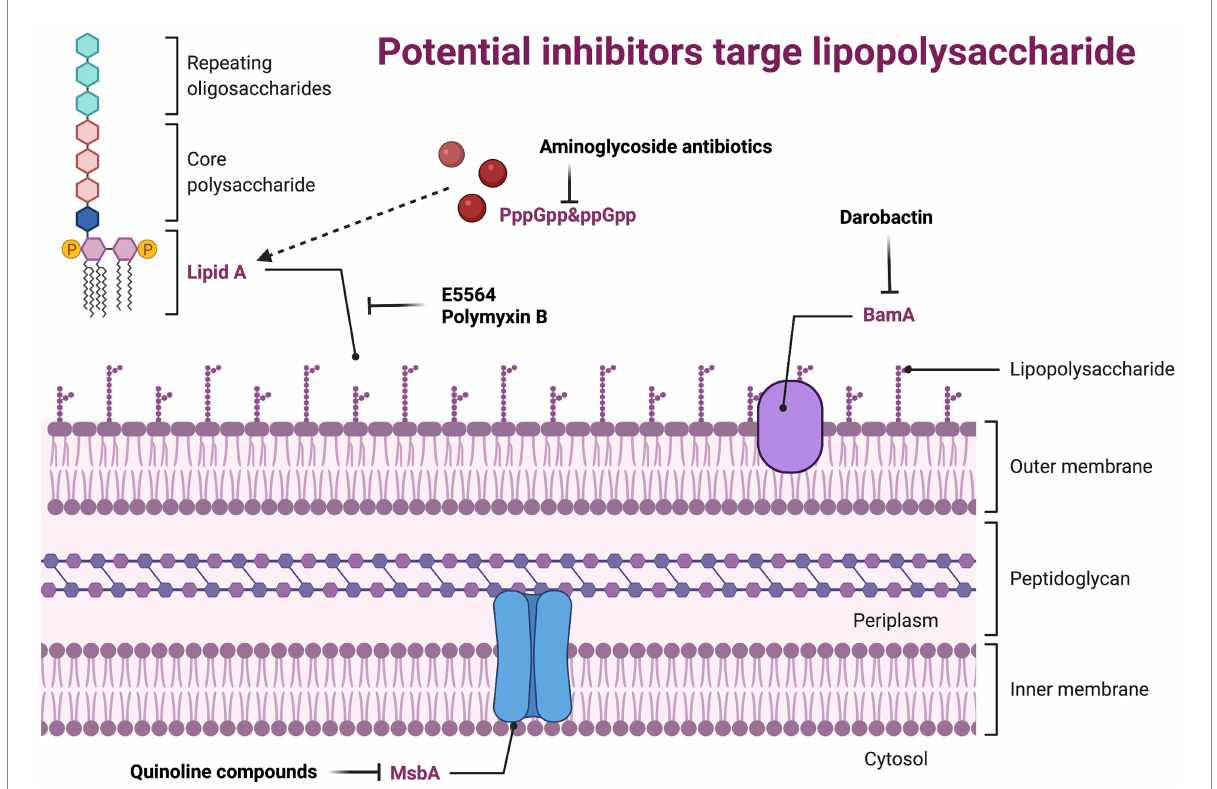
FIGURE 3 Potential inhibitors target lipopolysaccharide. BamA, the central component of the BamABCDE complex, it catalyzes both folding and insertion of nascent porins; MsbA, belongs to the ABC transporter superfamily, which reversely transports LPS from the intima leaflet synthesis site to the intima outer